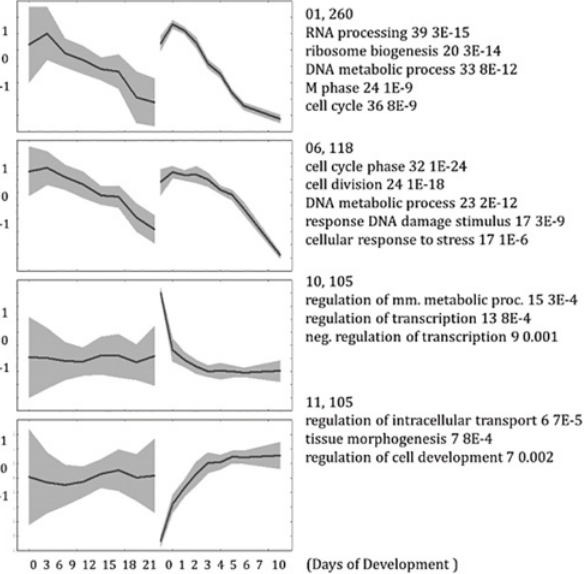
Fig 3. Selected clusters, annotated with GO terms. mESC profiles are clustered and shown on the right part of the graphs; respective hESC gene profiles are on the left. First 2 examples are for the most similar time-series expression, the other 2 – for the most dissimilar cases. This is an excerpt from S7